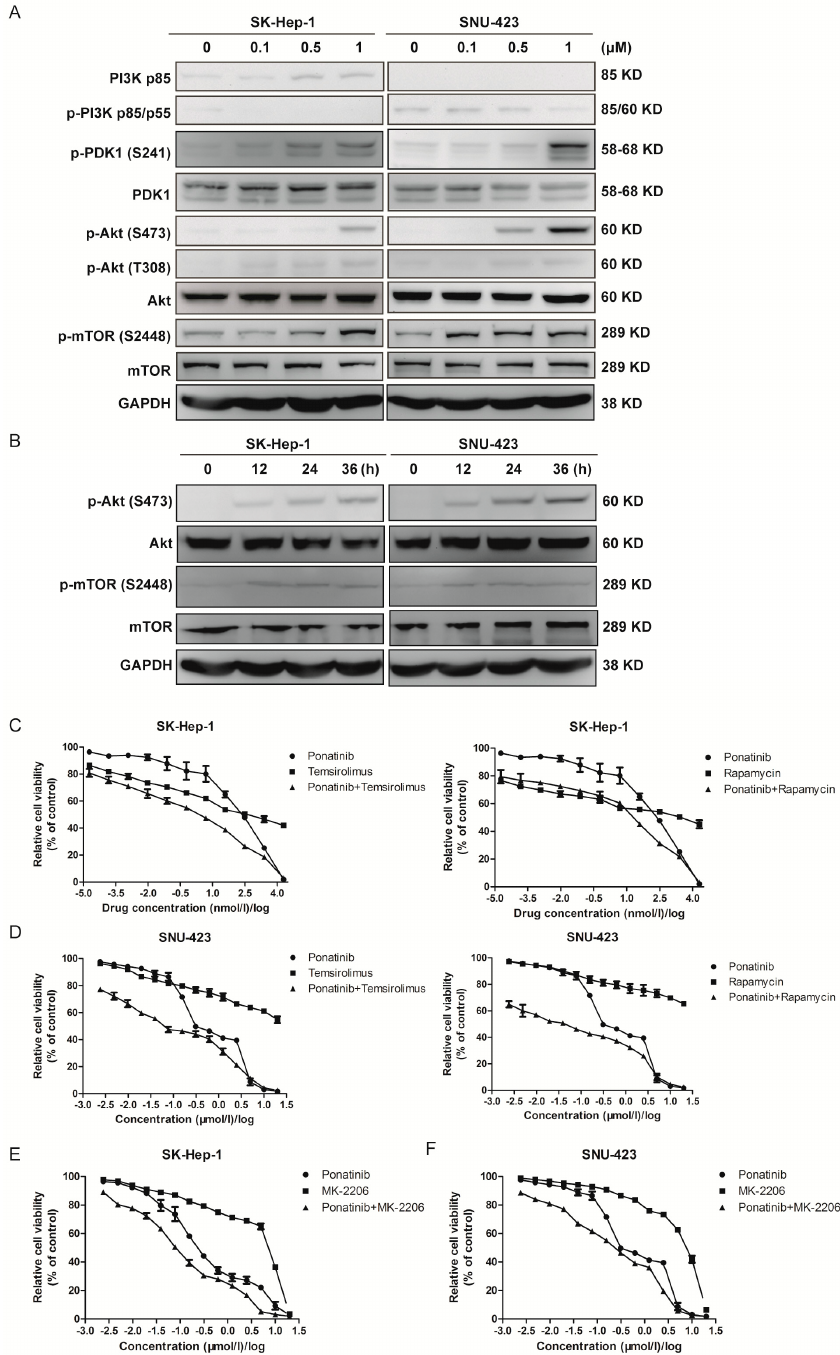
Figure 5. Effect of ponatinib on the protein kinase B (Akt)/mechanistic target of rapamycin (mTOR) signaling pathway. ( A ) Effects of ponatinib on the protein concentration and phosphorylation of PI 3-kinase, PDK1, Akt, and mTOR. ( B ) Time course of ponatinib (1 µ M) effect on the phosphorylation of Akt and mTOR. ( C ) Effect of ponatinib on SK-Hep-1 cell viability in the presence and absence of mTOR inhibitors, temsirolimus and rapamycin. ( D ) Effect of ponatinib on SNU-423 cell viability in the presence and absence of mTOR inhibitors, temsirolimus and rapamycin. ( E ) Effect of ponatinib on SK-Hep-1 cell viability in the presence and absence of an Akt inhibitor, MK-2206. ( F ) Effect of ponatinib on SNU-423 cell viability in the presence and absence of an Akt inhibitor, MK-2206. Table 3. Dose-response profiles of ponatinib+temsirolimus and ponatinib+rapamycin drug combinations.